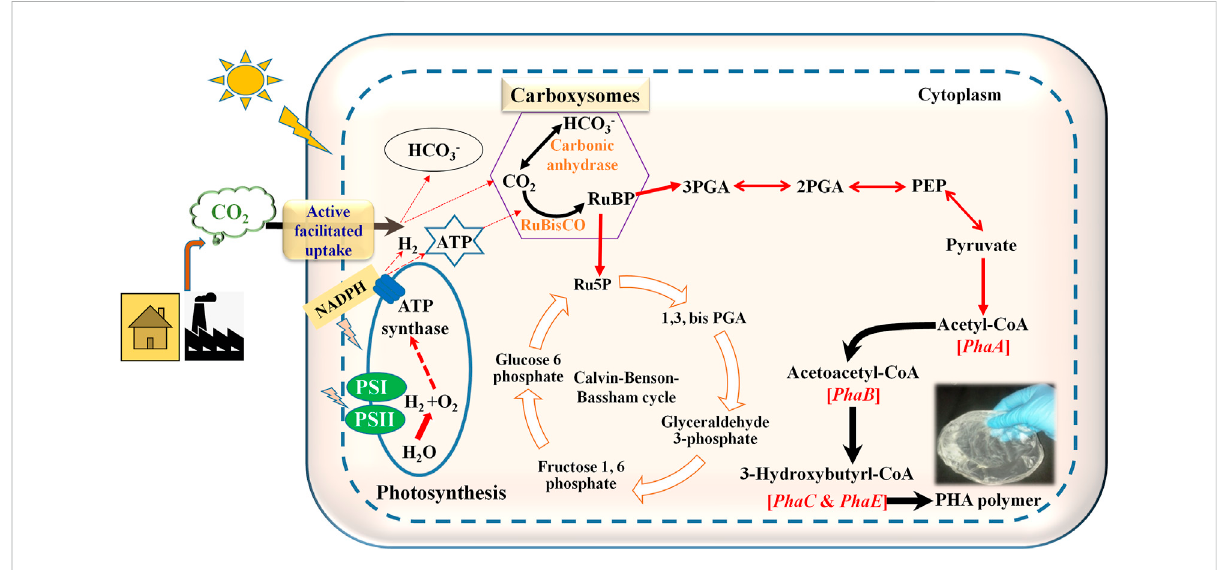
FIGURE 2 Schematic diagram showing PHA production pathway in cyanobacteria utilizing CO 2 as carbon source. RuBP: Ribulose I, 5 his phosphate; 3PGA: 3-phosphoglyceric acid; 2PGA: 2-phosphoglyceric acid; PEP: